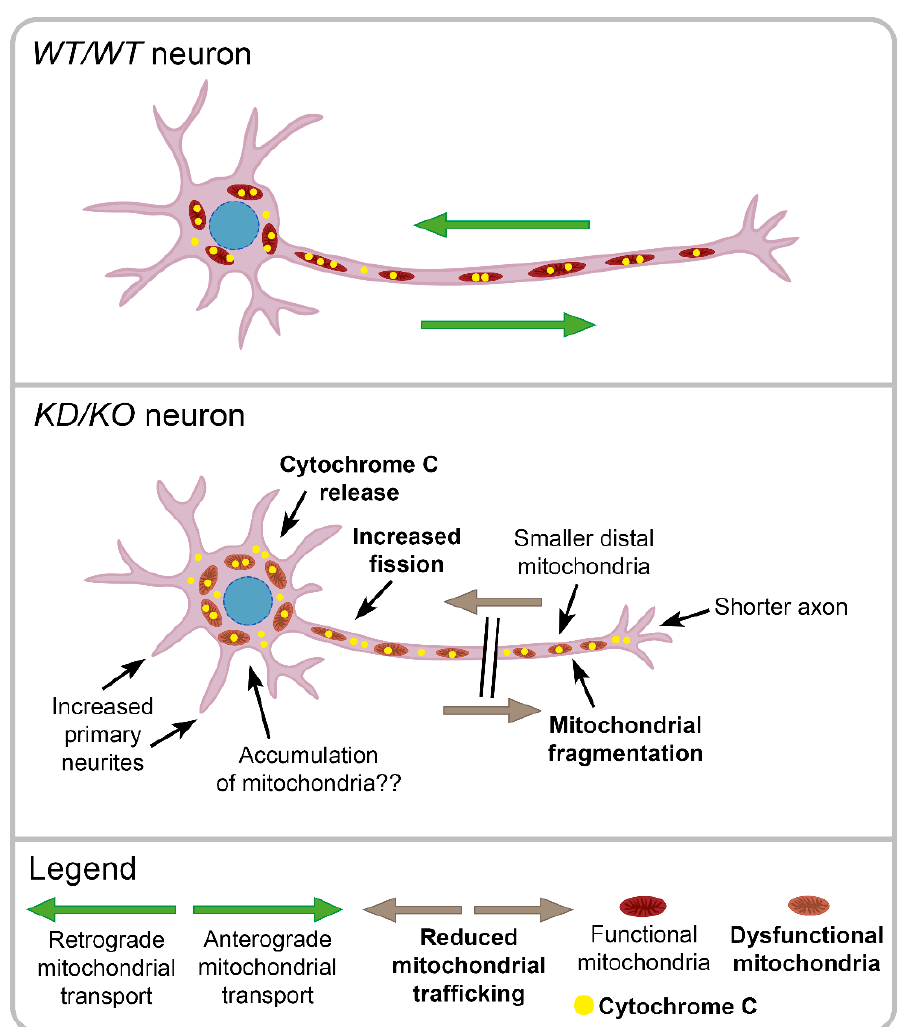
Figure 8. Model recapitulating mitochondrial and morphological alterations in the KD / KO mouse retinal and hippocampal neurons . KD / KO neurons show cytoarchitectural alterations, with an increased number of primary neurites and reduced axon length, compared to WT [16]. Besides, KD / KO neurons show dysfunctional mitochondrial (in orange) with an increase of mitochondrial fragmentation and fission events, a reduction of mitochondrial trafficking (brown arrows) and release of cytochrome C (in yellow) from mitochondria to cytosol. Our model proposes that Cerkl depletion causes altered distribution of mitochondria along the neuron, with an accumulation of mitochondria in the soma, an increase of fragmented mitochondria in the distal axon, and release of cytochrome C in the cytosol due to impaired mitochondria integrity (results from [11] and this work [highlighted in bold]). CERKL has been proposed as a resilience gene against oxidative stress and its pro- tective function is usually triggered by a challenge. In absence of stress conditions, over- expression of CERKL does not alter the mitochondrial network, in contrast, it clearly protects mitochondria from oxidative stress [13]. In this work, cultured neurons were